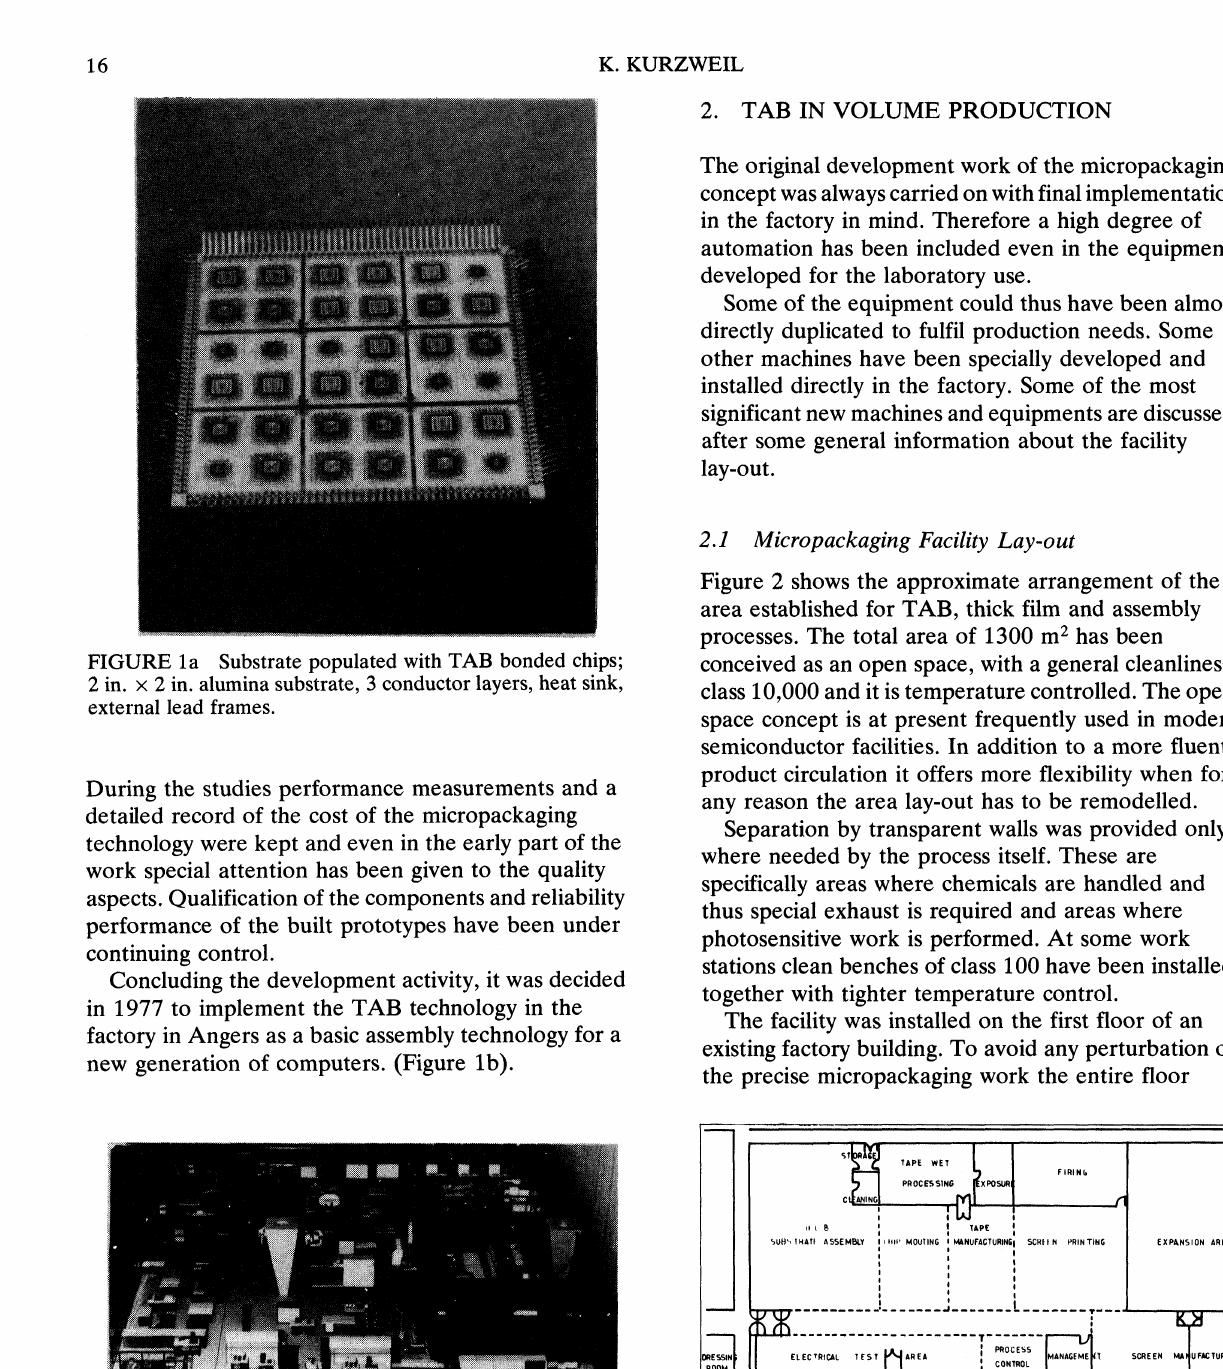
FIGURE b Partial view of manufacturing site. Reduced scale model.